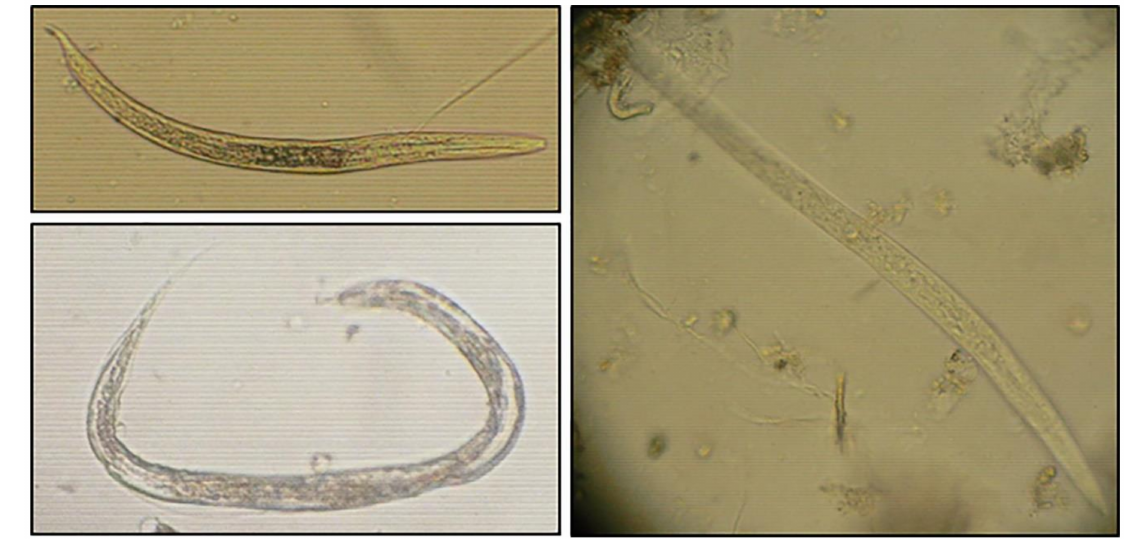
Figure 5. Light microscopic-isolated photos of rhabditoid larvae of nematodes identified in dried sludge samples.